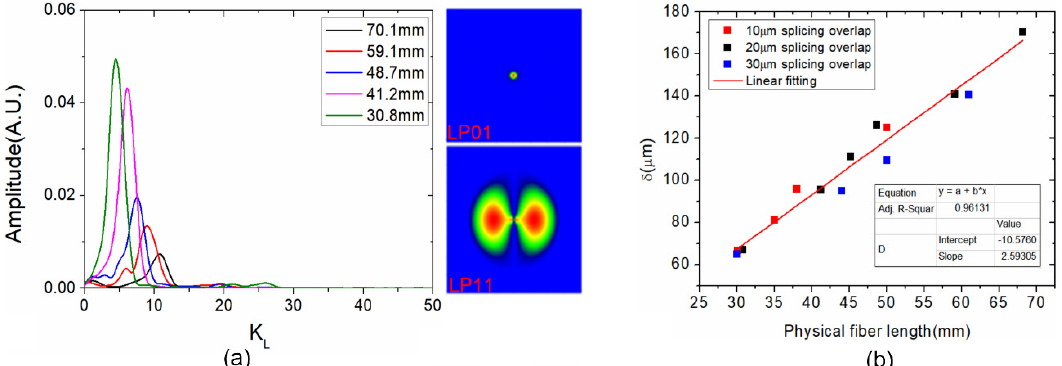
Figure 4. ( a ) Spectra after FFT for the WWFT-based interferometers with different interferometer lengths, inset: Electric field distributions of LP 01 and LP 11 mode; ( b ) Optical path difference versus interferometer length with overlaps of 10 μ m, 20 μ m and 30 μ m, respectively.